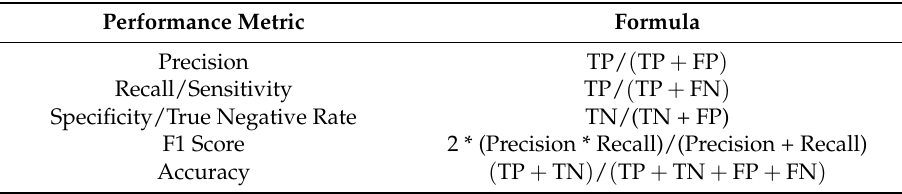
Table 7. Performance metrics for the classification model.